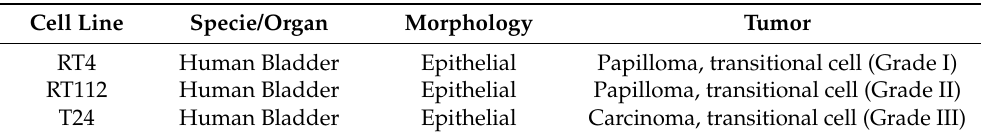
Table 1. Characteristics of the bladder cancer cell lines used in this work. Cell